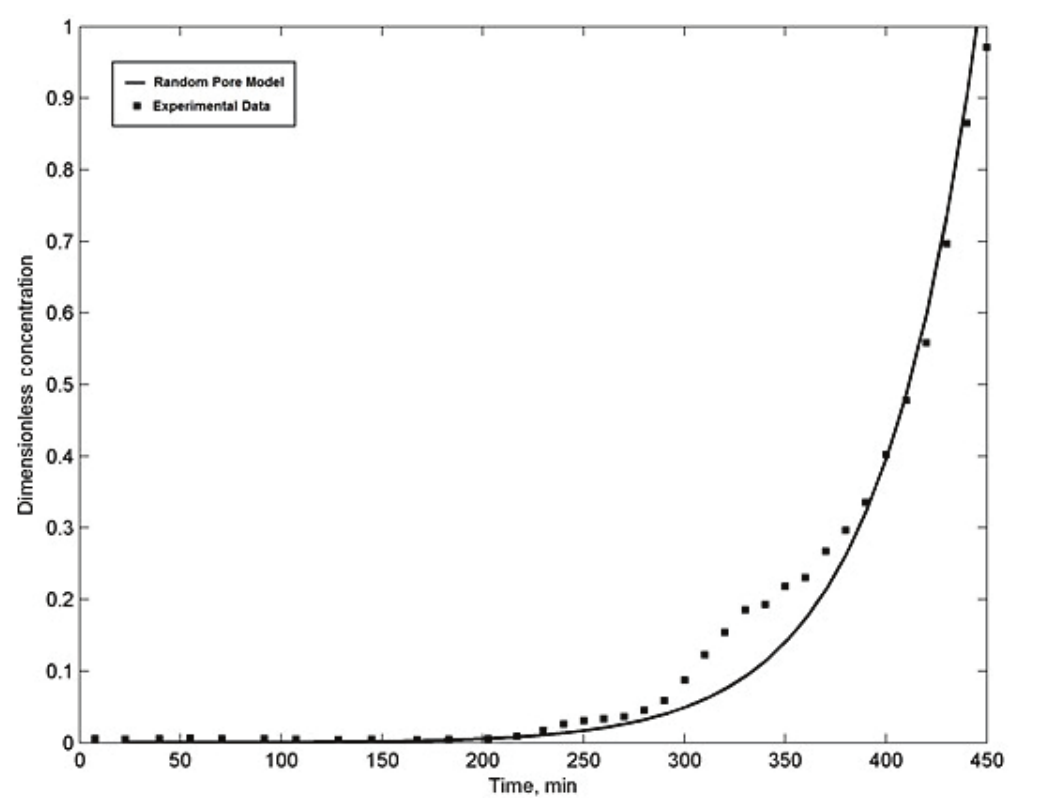
Fig. 3 – Comparison between random pore model predictions and experimental SO at base case (600 °C, 1 vol.% SO